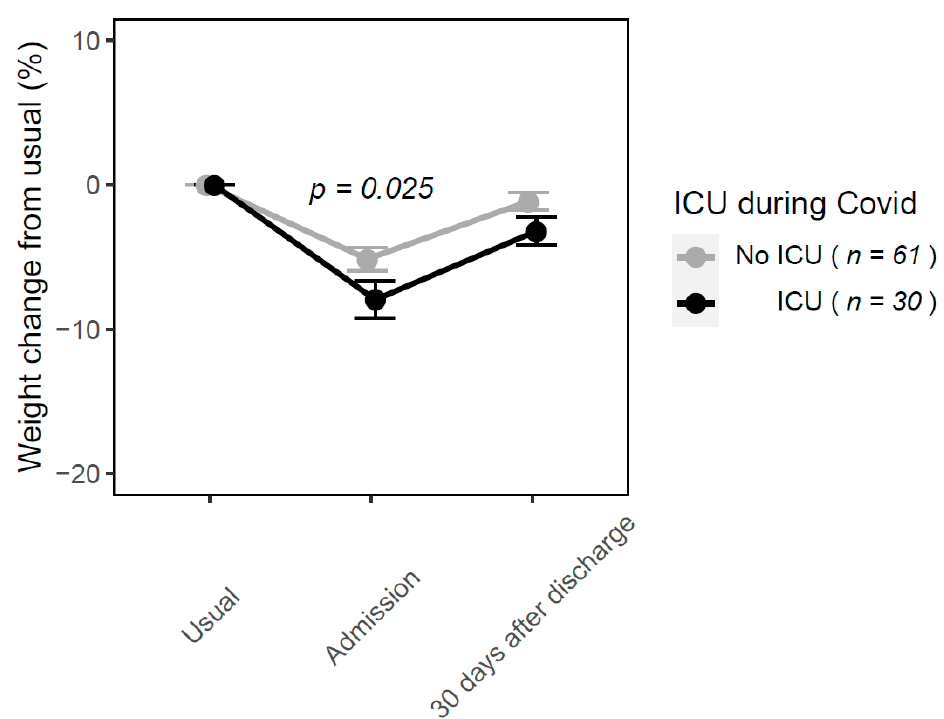
Figure 2. Mean weight change (%) in COVID-19 patients depending on whether patients were transferred to ICU or not during hospital stay.